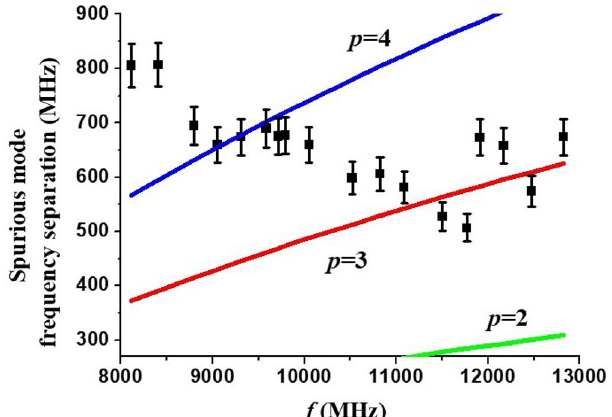
Figure 7. The frequency separation between band-pass filter center frequency and the largest spurious mode. Dots—experimental data, solid